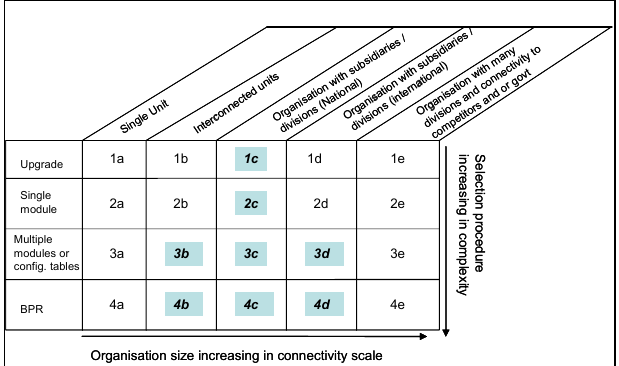
Figure 1: Matrix of size and complexity of selection procedure with position of organisation examined in this investigation